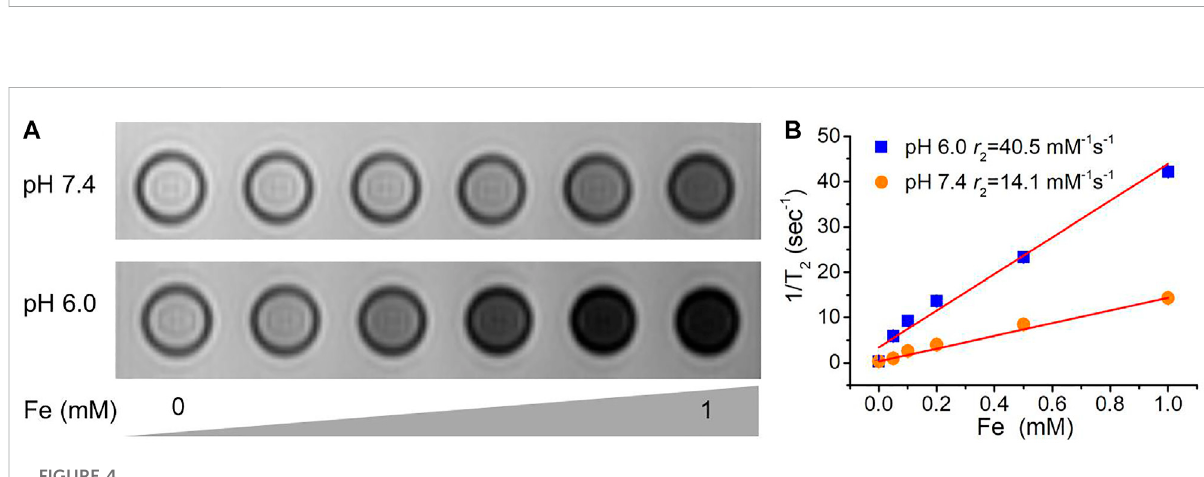
FIGURE 4 (A) T 2 -weighted MR images of the supernatants obtained from Fe/Ce-MSN NPs in FBS solution at different pH values (7.4 and 6.0). (B) The r 2 values from T 2 -weighted MR images of Fe/Ce-MSN NPs incubated in above